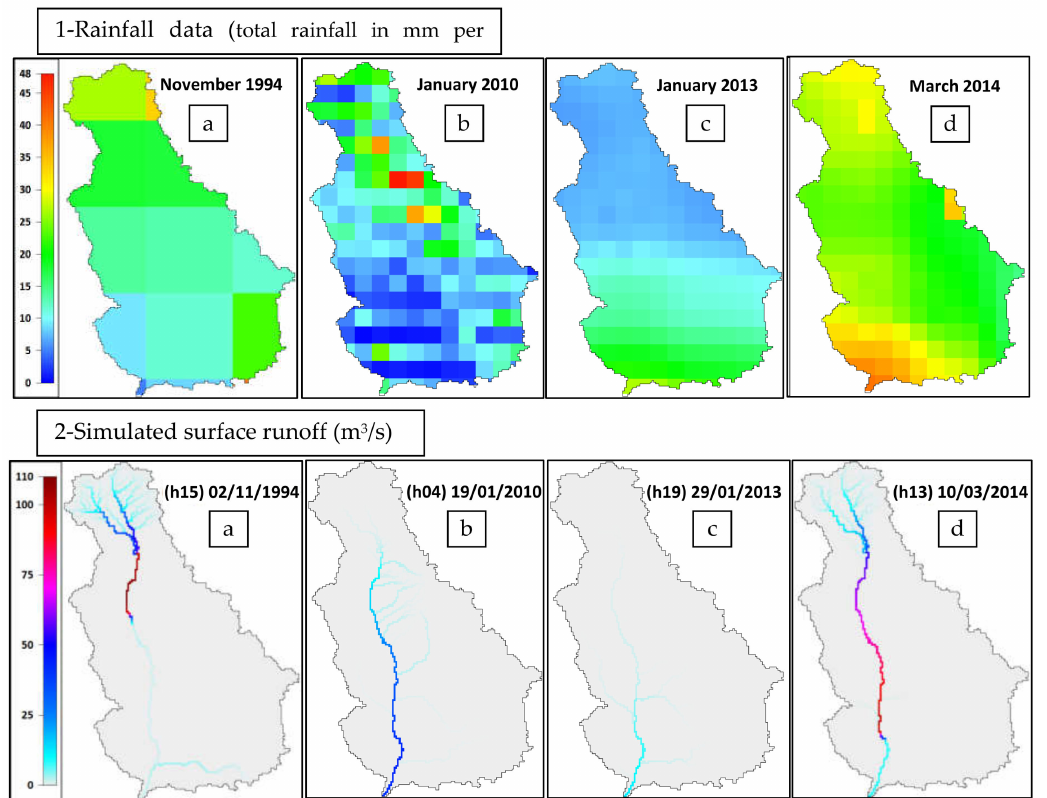
Figure 9. Geographical distribution maps at Wadi Qena for ( 1 ) total rainfall input; ( 2 ) simulated peak surface runoff for the ( a ) November 1994, ( b ) January 2010, ( c ) January 2013 and ( d ) March 2014 flood events. The rainfall data of Nov. 1994 event were used form Geith and Sultan [48] with a resolution of 0.5 degree whereas the GSMaP data of 0.1 degree resolution were used for the other